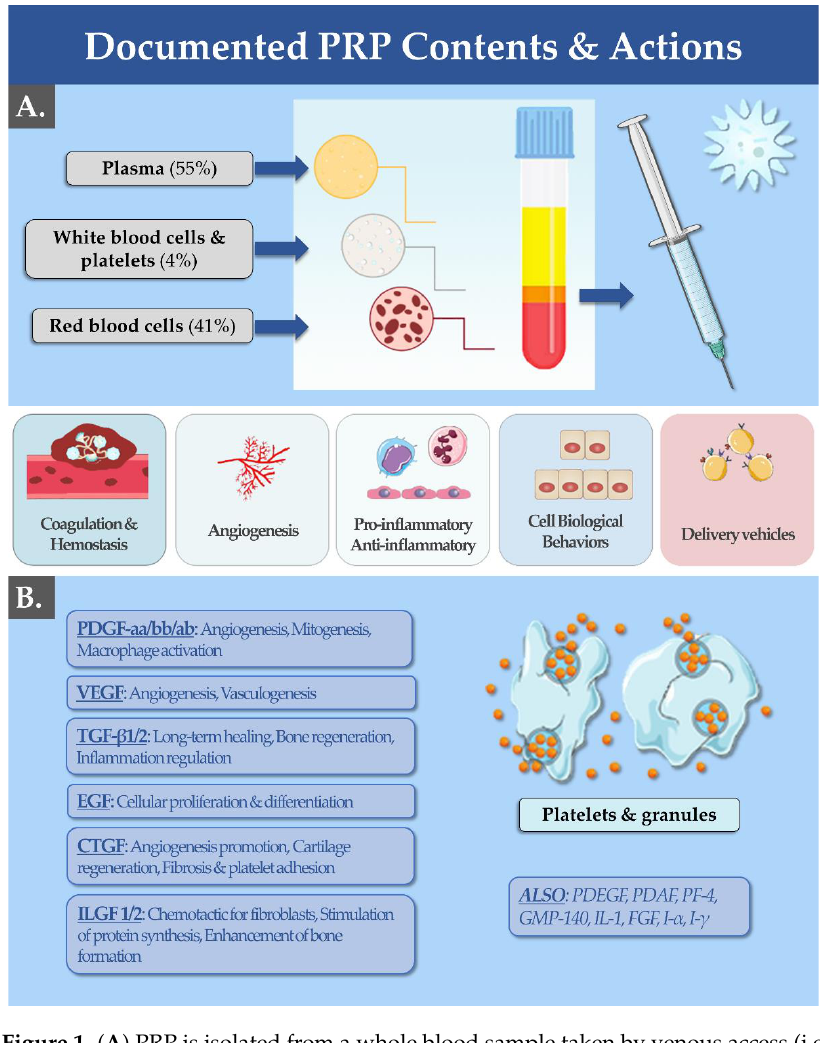
Figure 1. ( A ) PRP is isolated from a whole blood sample taken by venous access (i.e., ≥ 20 cc needed depending on the indication). Concentrated platelets are obtained by centrifugation of autologous blood in a 2-step procedure, aiming to eliminate RBC and to prepare a 2–5X concentrate of platelets in the isolated plasma volume. The mechanisms of action of PRP in regenerative medicine are implicated at all stages of wound healing (e.g., coagulation, angiogenesis, inflammation) due to the various growth factors available in the biological preparations. ( B ) Listing of the most common growth factors found in PRP, along with their documented effects. Cc, cubic centimeters; CTGF, connective tissue growth factor; EGF, epidermal growth factor; FGF, fibroblast growth factor; GMP-140, platelet alpha- granule membrane protein; IL, interleukin; ILGF, insulin-like growth factor; PDAF, platelet-derived angiogenesis factor; PDGF, platelet-derived growth factor; PF, platelet factor; PRP, platelet-rich plasma; RBC, red blood cells; TGF, transforming growth factor; VEGF, vascular endothelial growth